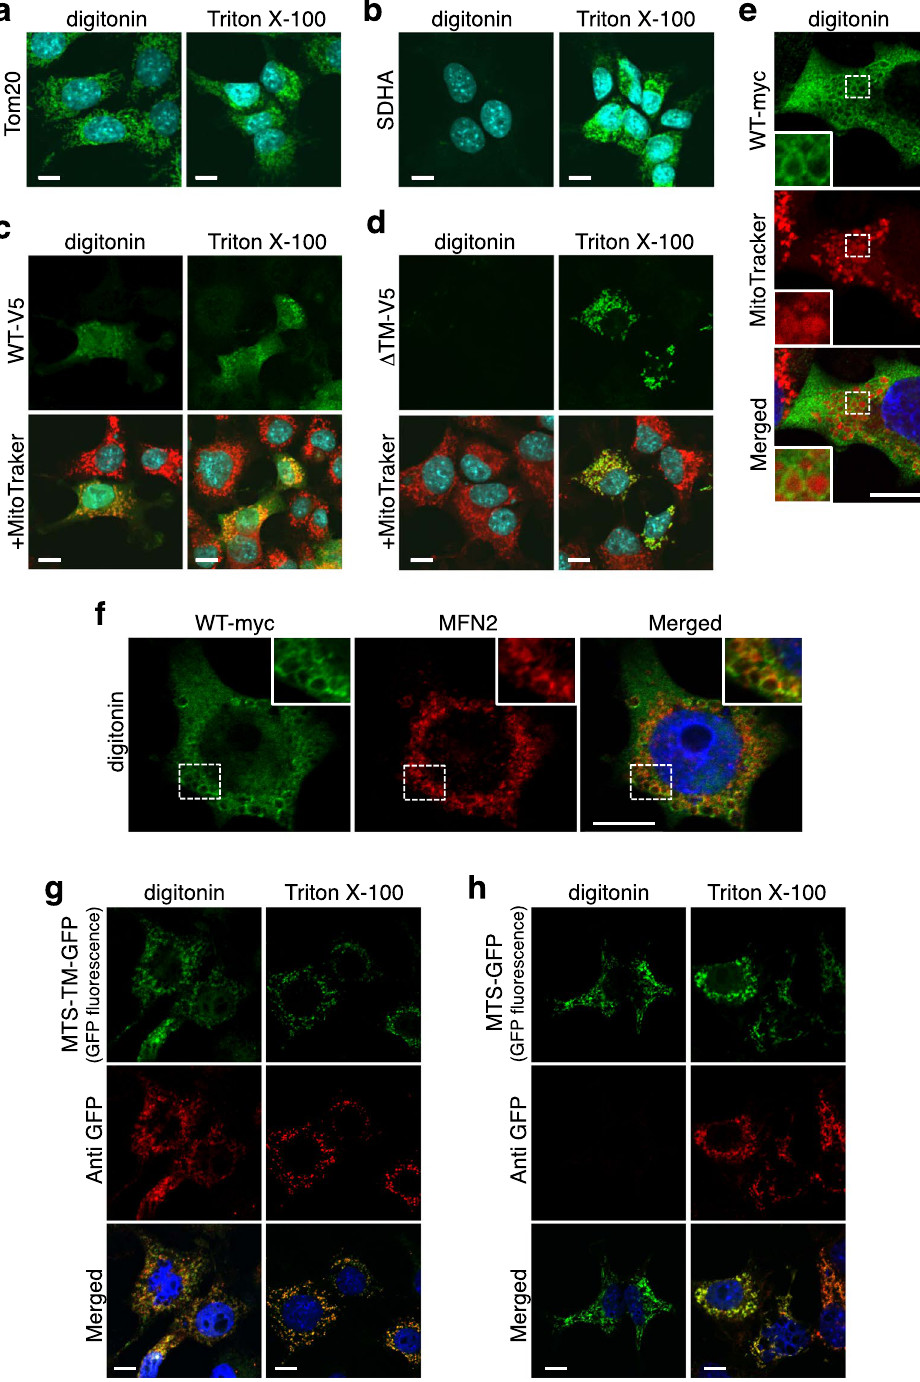
Figure 5. Immunocytochemical distribution of wild type or Δ TM StarD7 over-expressed in HEPA-1 cells. ( a and b ) HEPA-1 cells were permeabilized with 0.005% digitonin (w/v) or 0.1% Triton X-100 (w/v), then immunostained with anti-TOM20 ( a ) or –SDHA ( b ) antibodies followed by anti-mouse IgG Alexa488 (green). ( c , d and e ) HEPA-1 cells were transfected with the expression vector for WT-V5 ( c ), Δ TM-V5 ( d ), or WT-myc ( e ), permeabilized with 0.005% digitonin (w/v) or 0.1% Triton X-100 (w/v), then immunostained with anti-V5 or -myc antibodies followed by anti-mouse IgG Alexa488 (green) and MitoTracker Red (red). ( f ) HEPA-1 cells transfected with WT-myc were permeabilized with 0.005% digitonin (w/v) and immunostained using anti-myc and -MFN2 antibodies followed by anti-mouse IgG Alexa488 (green) and anti-rabbit IgG Alexa594 (red), respectively. ( g and h ) HEPA-1 cells were transfected with the expression vector for MTS-TM-GFP ( g ) or MTS-GFP ( h ), permeabilized with 0.005% digitonin (w/v) or 0.1% Triton X-100 (w/v), then immunostained with anti-GFP antibody followed by anti-mouse IgG Alexa594 (red). Nuclei were stained with DAPI (blue). Bars indicate 10 μ